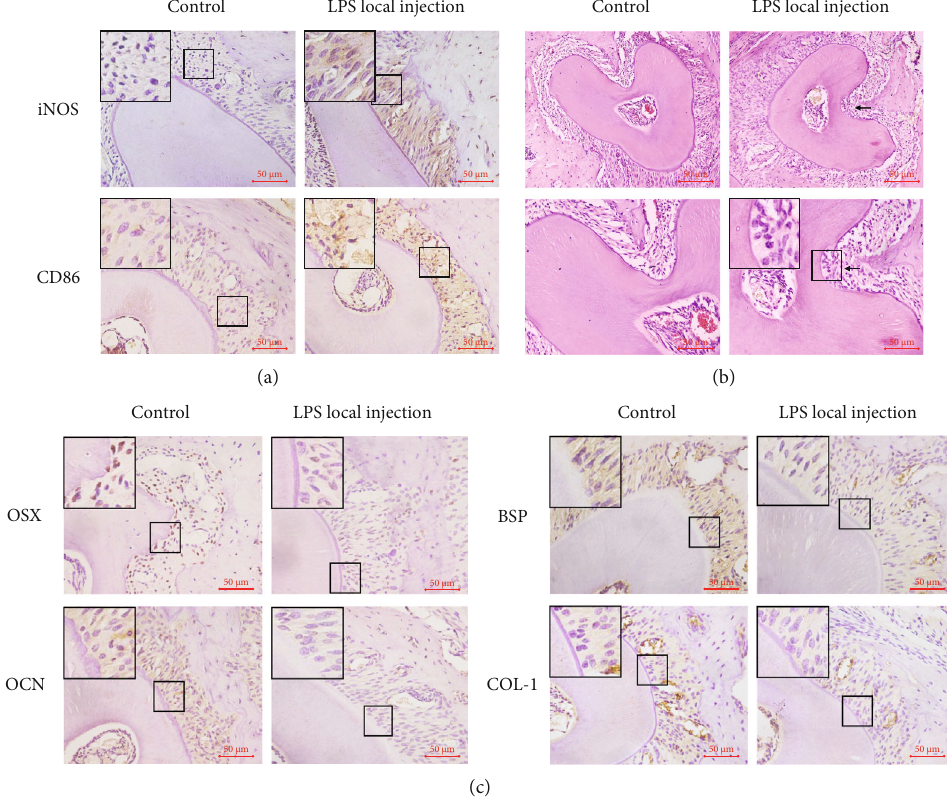
Figure 7: Root resorption, M1/M2 accumulation, and cementoblast mineralization in the local injection model. (a) Representative immunohistochemical images of iNOS and CD86 in the roots of maxillary molars in the control and LPS local injection groups. Scale bars: 50 μ m. (b) Representative images of HE staining in the roots of maxillary molars in the control and LPS local injection groups. Black arrows indicate the root resorption zone. Scale bars: 100 μ m/50 μ m. (c) Representative immunohistochemical images of OSX, OCN, BSP, and COL-1 in the roots of maxillary molars in the control and LPS local injection groups. Scale bars: 50 μ